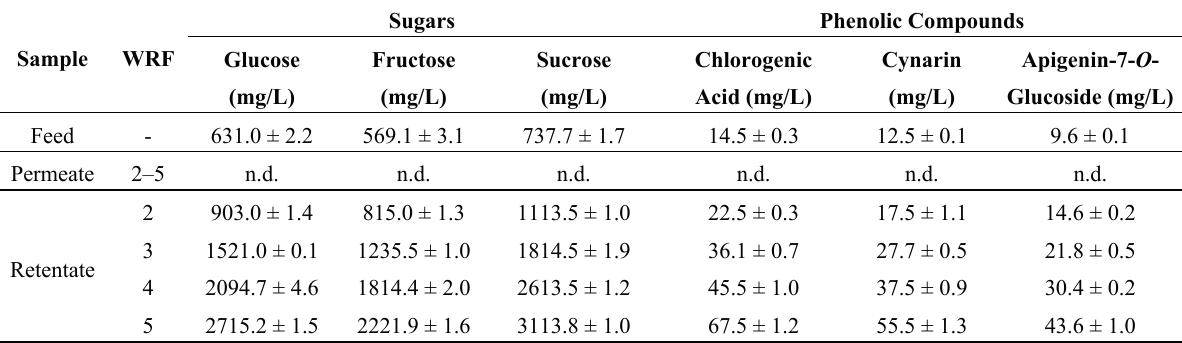
Table 4. Analyses of sugars and phenolic compounds in samples coming from the treatment of the NP030 permeate stream with the Desal DK